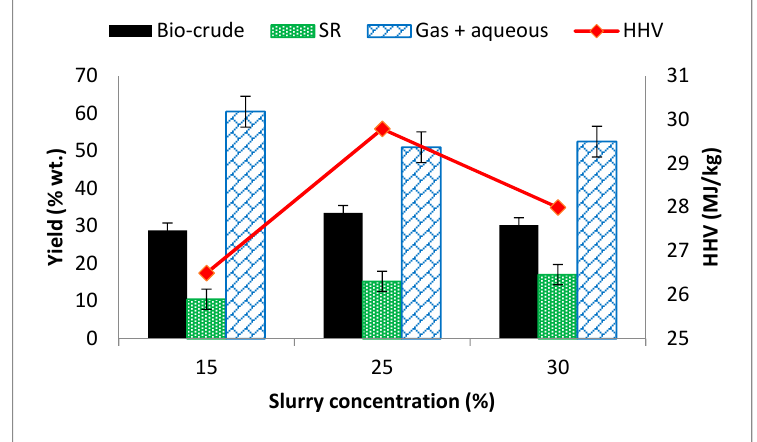
Figure 4. Effect of slurry concentration on the recovery of bio-crude, solids and gas + aqueous components after HTL treatment (350 °C, 60 min). Standard deviations are based on two replicates; values provided are for yield data.